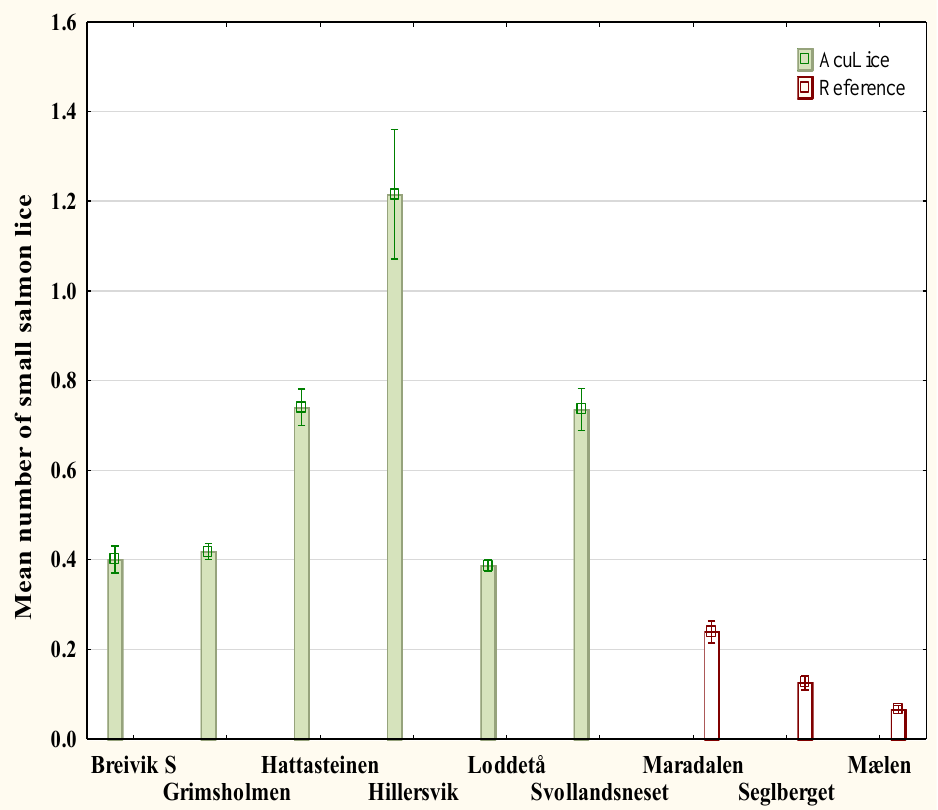
Figure 4. Mean specific growth rate (SGR (% day -1 )) calculated for Atlantic salmon at each experi- mental facility in field trial 2 in the period from mid-summer 2019 to late-spring 2020. The AcuLice- treated facilities are marked in green, and the reference group is marked in red. Data from each production facility is presented as mean ± SEM (N = 30). Note that data from the reference facility Seglberget is missing due to missing weight measurements.